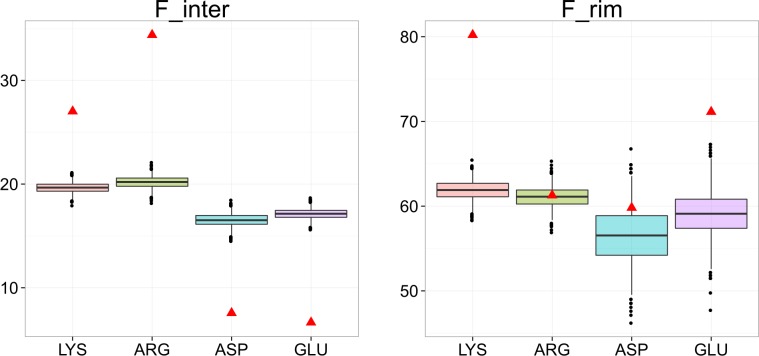
Frequency of charged residues in protein-DNA interfaces.Data are collected on a list of 303 protein-DNA complexes, non-redundant at the 70% level. F_inter: fraction of residues of a given type in interfaces. F_rim: fraction of residues of a given type in rim regions, among those in interfaces. Each box plot displays the distribution of simulated values computed from 1000 random data sets. Box edges correspond to the 25th and 75th percentiles, the notches extend from the 1st to the 99th percentiles, and black points are outliers. Observed fractions are depicted as red triangles. Pink boxes: lysine residues, green boxes: arginine residues, blue boxes: aspartate residues, purple boxes: glutamate residues.